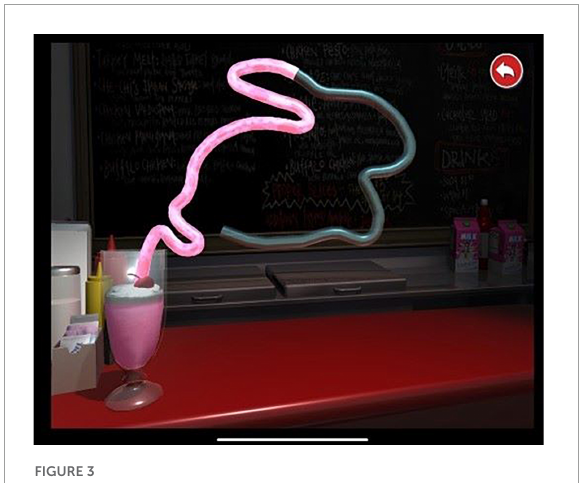
FIGURE3 Lee Ryan Hand Co-ordination Test